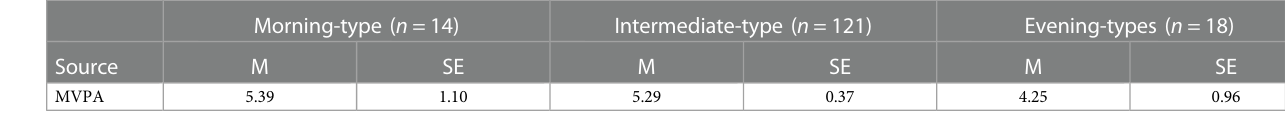
TABLE 8 Chronotype group differences in MVPA ( N =153).